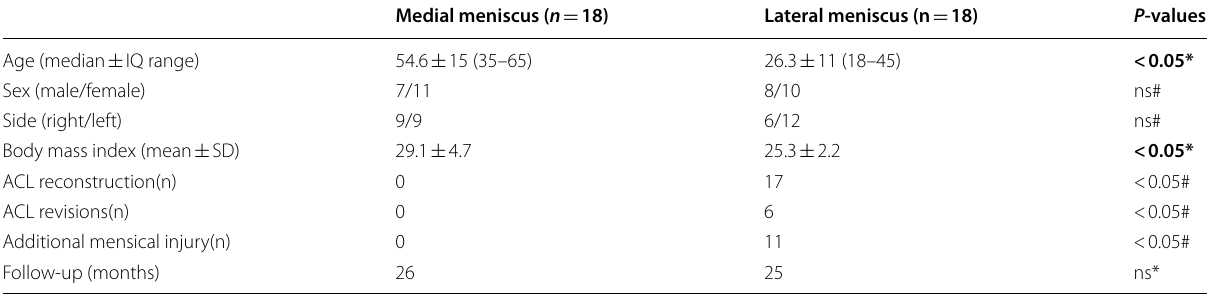
Table 1 Baseline demographics and surgical data of study patients with posterior meniscal root repairs for the medial and lateral meniscus